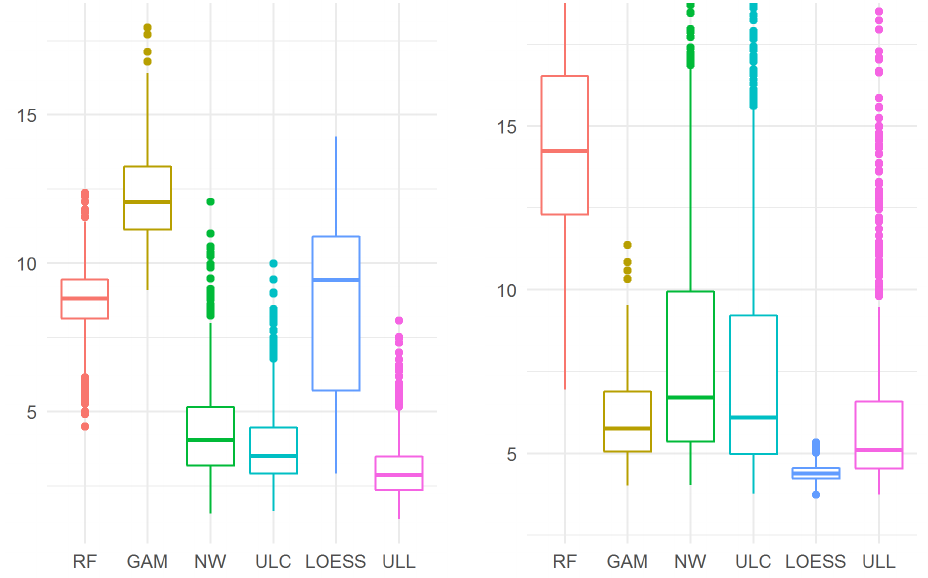
Figure 7. The maximum ( left ) and mean-squared ( right ) errors in Example 5. As before, for the mean-squared error, the results of the random forest model are not shown in full on the graph. In addition, the outliers for the NW, ULC, and ULL estimators are “cut off” in this